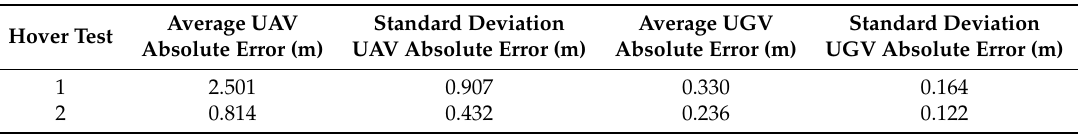
Table 3. Average and standard deviations of errors in hover tests shown in Figures 12 and 13. The results for the second test exclude the data from the UAV during the period of RTK failure. Hover